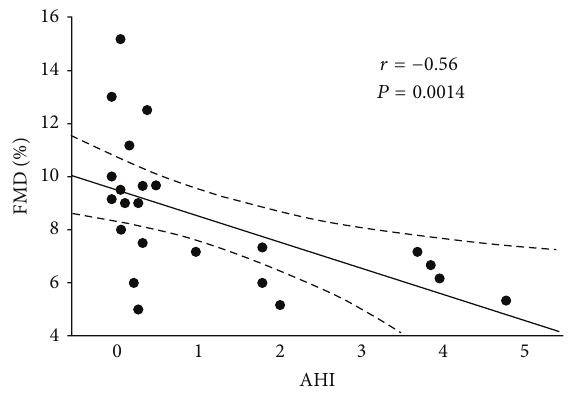
Figure 1: Correlation between FMD% and AHI in Group 1 ( 𝑟 = −0.56 , 𝑃 = 0.0014 ).